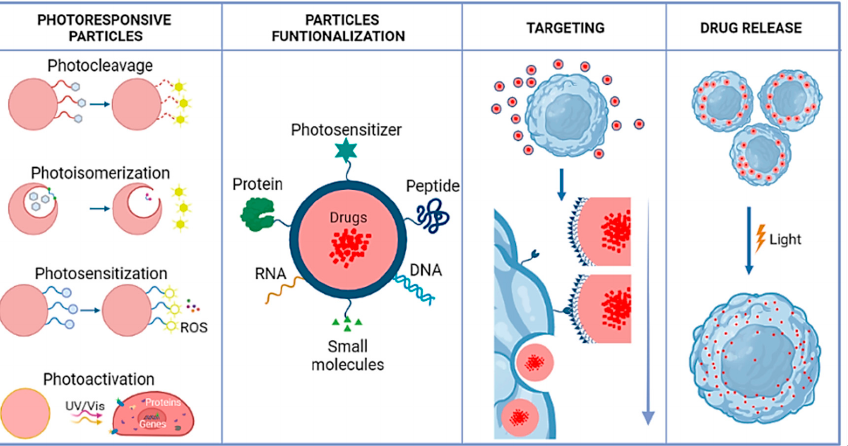
Figure 1. Schematic illustration of photosensitive polymeric nanocarriers: photosensitive mechanism, functional nanocarriers, nanocarriers targeting, and drug release.